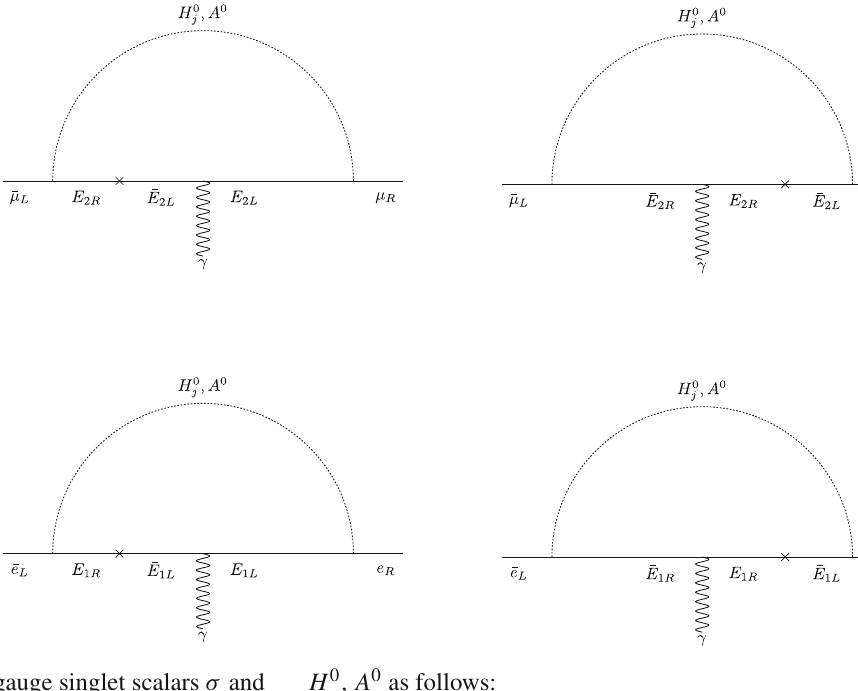
Fig. 1 Leading Loop Feynman diagrams contributing to the muon and electron anomalous magnetic moments. Here E 1 , 2 , are components of the S 3 -doublet and j = 1 , 2 , 3 ,